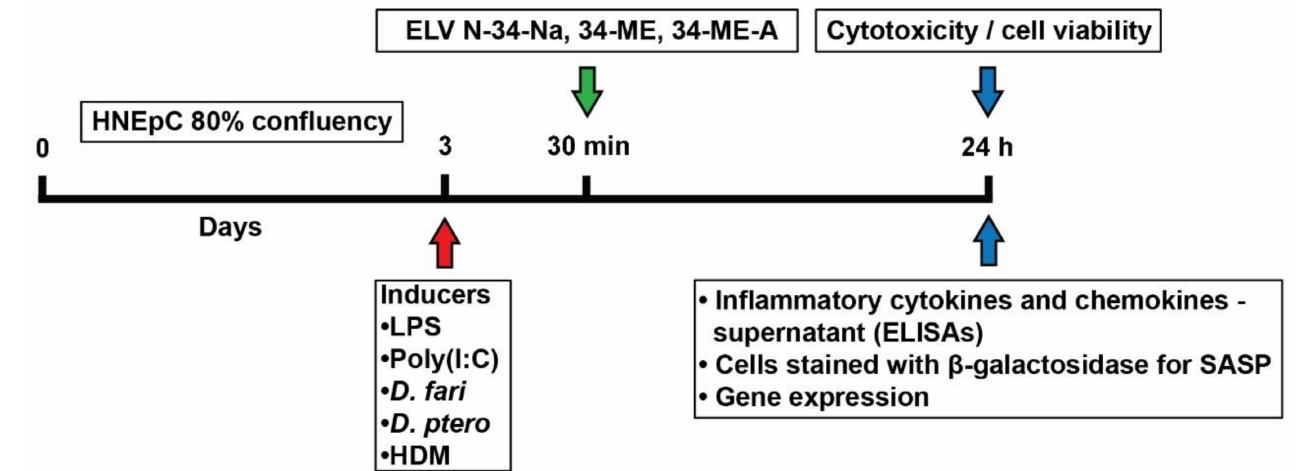
Figure 1. Experimental design. Human nasal epithelial cells (HNEpC) in primary culture challenged by allergy inducers—LPS, poly (I:C), D. fari, D. ptero, or a combination of house dust mite